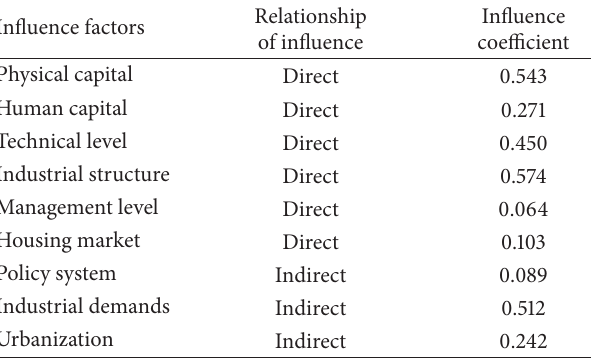
Table 8: The influence of the change of the pattern elements of construction